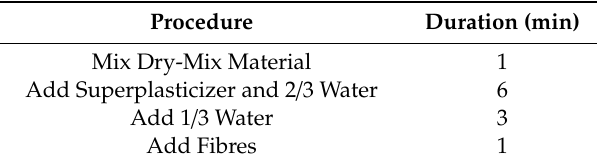
Table 3. Mixing procedure and time for premix UHPFRC.